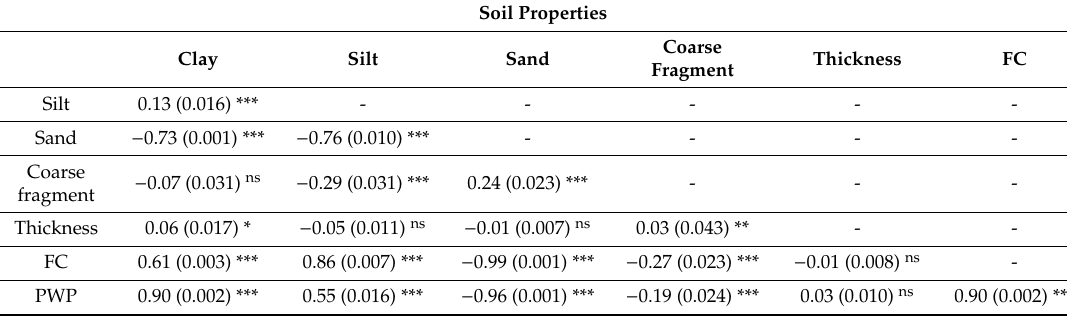
Table 4. Soil layer properties combinations averaged on soil profiles when soil layers are support SAWC